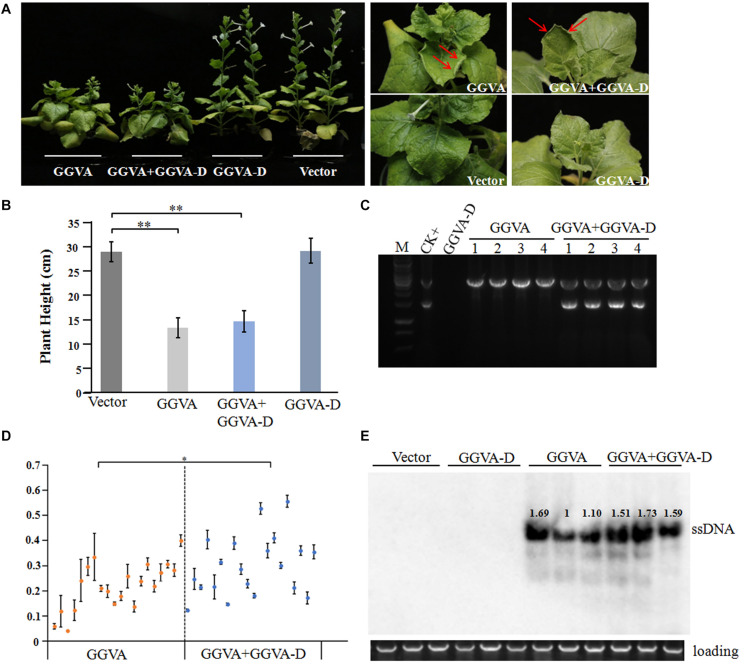
Systemic infection of GGVA and GGVA-D in Nicotiana benthamiana. (A) Symptoms induced by GGVA and GGVA-D alone or in combined infection in N. benthamiana plants. The red arrow points to a curled leaf. (B) Height of N. benthamiana infected by GGVA and GGVA-D alone or in combination. Significant differences assessed using a T-test (P < 0.01) are shown by ∗∗. (C) The electrophoresis diagram of digested RCA products with BamHI that derived from GGVA and GGVA-D alone or combined infection in N. benthamiana plants. The result of the field sample 17YM1 was used as the positive control. (D) Analysis of the accumulation level of GGVA in N. benthamiana plants infected by GGVA alone or by GGVA/GGVA-D together at 30 dpi using qPCR. Each scatter point in the figure represents a biological replicate, and the error line was drawn for the three technical replicates of each biological replicate. Significant differences assessed using a T-test (0.01 < P < 0.05)are indicated by ∗. (E) Accumulation of GGVA in inoculated plants as detected using Southern blotting hybridization with a probe specific to the GGVA genome. Three biological replicates for per inoculation column were set.